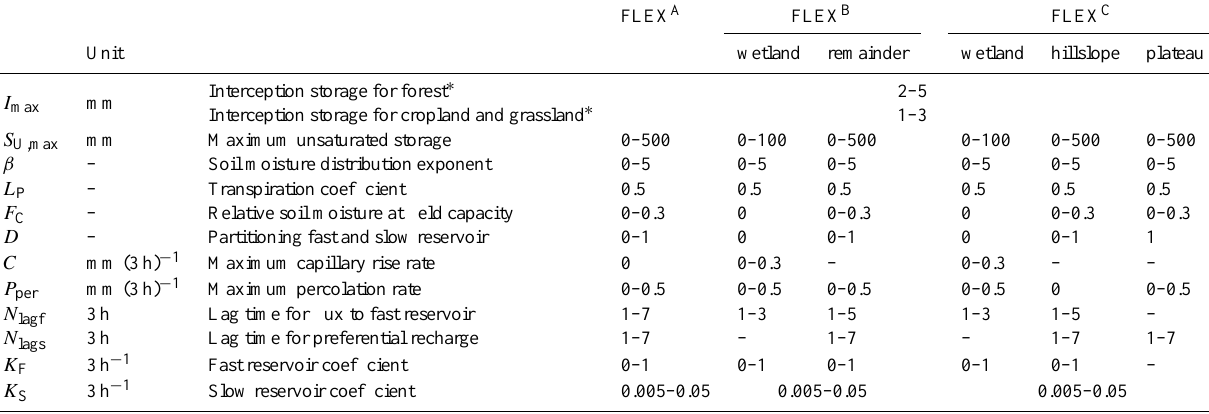
Table 1. Uniform prior parameter distributions for the three model setups.